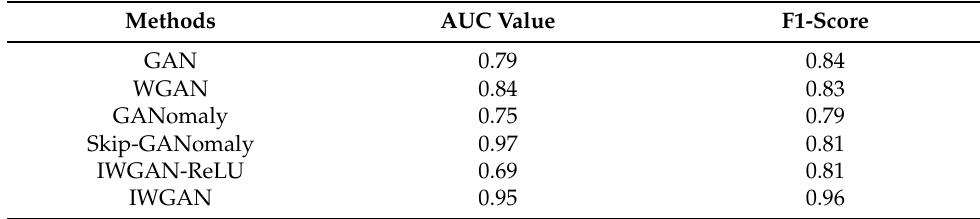
Table 4. The AUC value and F1-score of each